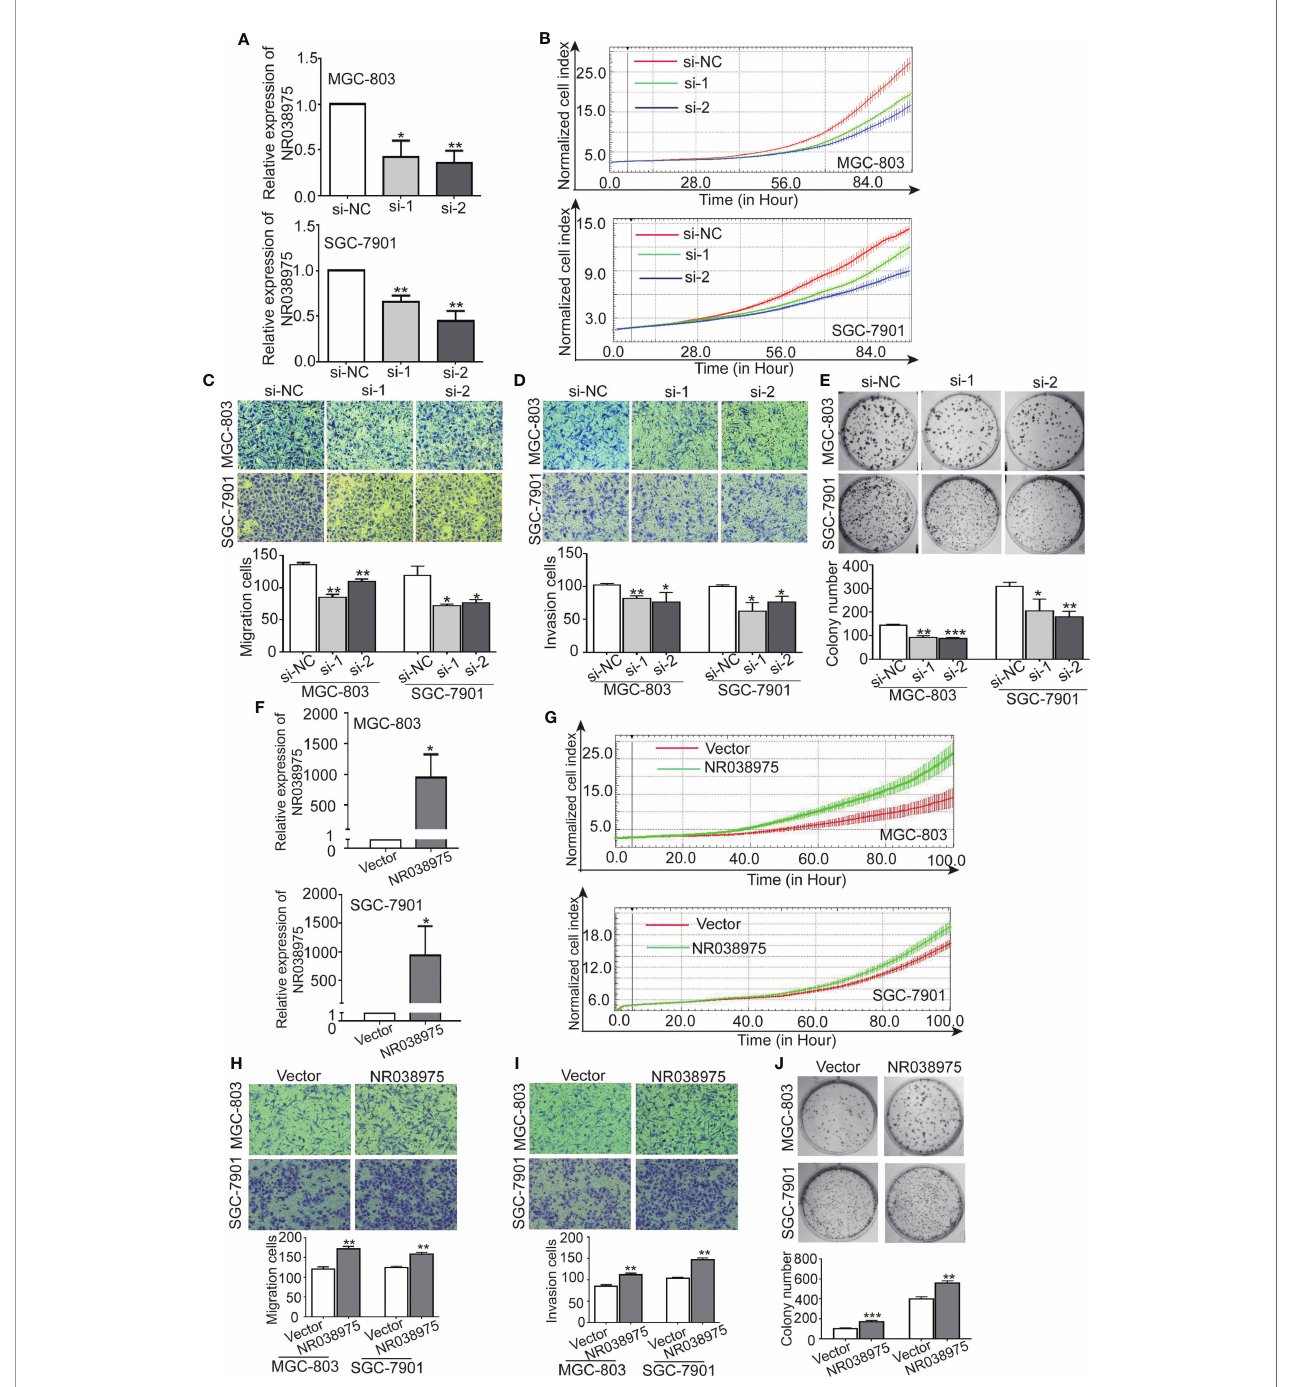
FIGURE 2 | Inhibition of NR038975 reduced the proliferation, migration, invasion, and clonogenicity of gastric cancer (GC) cells. (A) The expression of NR038975 was detected by qRT-PCR in SGC-7901 cells and MGC-803 cells transfected with the small interfering RNA (siRNA) for 24 h, *p < 0.05. (B) Proliferation of GC cells with NR038975 knockdown was assessed by Real-Time Cell Analyzer (RTCA) system. (C, D) The effect of NR038975 knockdown on the migration and invasion of GC cells was investigated using the Transwell and Matrigel assay, respectively. Average counts were collected from fi ve random microscopic fi elds, *p < 0.05. (E) Knocking down NR038975 inhibited the clonogenicity of GC cells; the number of colonies was calculated and plotted on a histogram, *p < 0.05. (F) The expression of NR038975 was detected by qRT-PCR in SGC-7901 and MGC-803 cells transfected with the plasmid for 24 h, *p < 0.05. (G) Proliferation of GC cells with NR038975 overexpression was assessed by RTCA system. (H, I) The effect of NR038975 overexpression on the migration and invasion of GC cells was investigated using the Transwell and Matrigel assay, respectively, *p < 0.05. (J) The effect of NR038975 overexpression on the clonogenicity of GC cells, *p < 0.05, **p < 0.01, ***p <